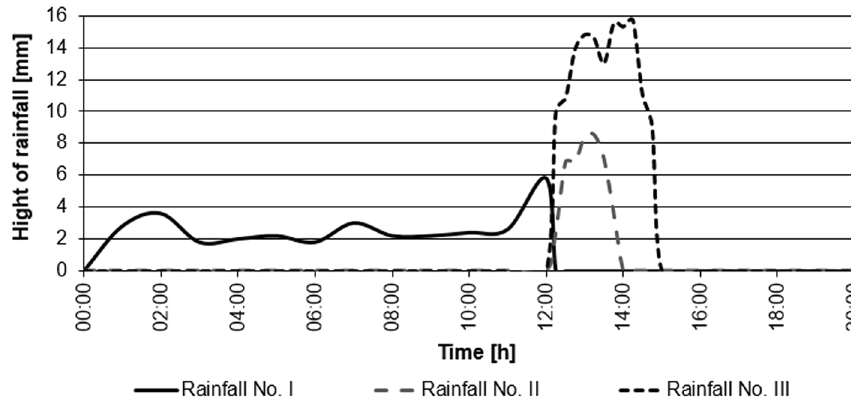
Fig. 4 Distribution of applied rainfall events in time